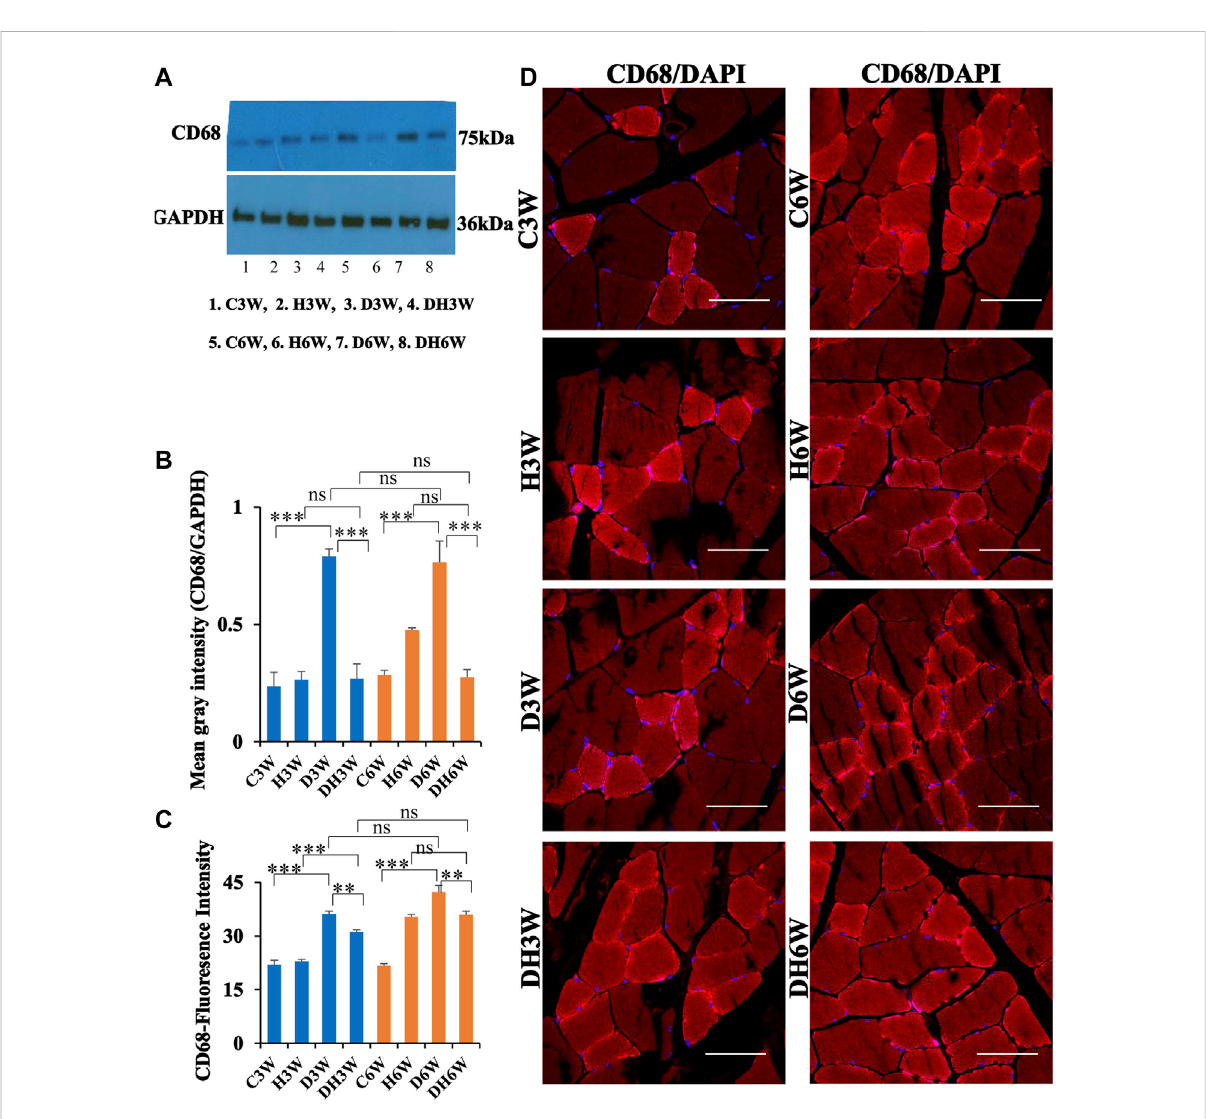
FIGURE 7 (A,B) Immunoblots probed with anti-CD68 antibody (A) and the mean gray intensity of immunoblots (B) . Note the signi fi cantly increased expression of CD68 (mean gray intensity) in D3W and D6W comparedto C3W and C6W respectively. CD68 expressionwas decreased in DH3W and DH6WcomparedtoD3WandD6Wrespectively. Therewasnosigni fi cantdifferenceinCD68expressionfromshort-term(D3WandDH3W)tolong- term(D6WandDH6W). (C,D) CD68immuno fl uorescenceintensity (C) andrepresentativecross-sectionofmuscle fi bersstainedforanti-CD68 immuno fl uorescence in short-term (left panel) and long-term (right panel) experiments (D) . Western blot data of CD68 expression was further supportedby fl uorescenceintensitymeasuredontheanti-CD68immunostainedsectionsofthemuscle fi bersinmostofthecomparisons.Notethat manymuscle fi bersshow immuno fl uorescenceinD3W,DH3W,D6W,andDH6W(***, p < 0.001,One-wayANOVA, Bonferroni multiplecomparison tests, n = 6 in all groups). Scale bar = 50